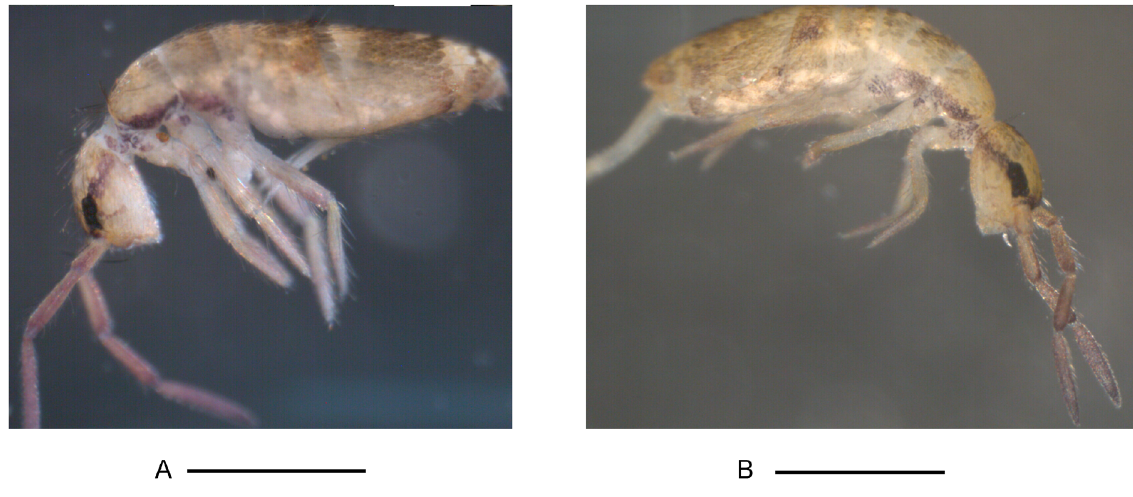
Fig. 1. Willowsia sexachaeta sp. nov. A−B . Habitus. Scale bars: 500